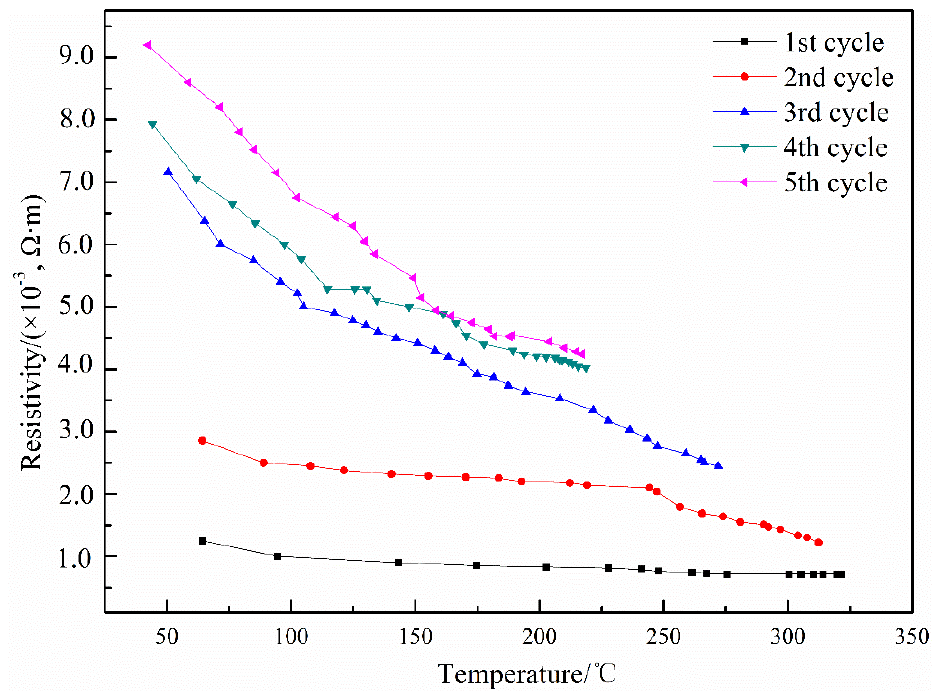
Figure 10. The resistivity–temperature curves of coating in the heating stage.